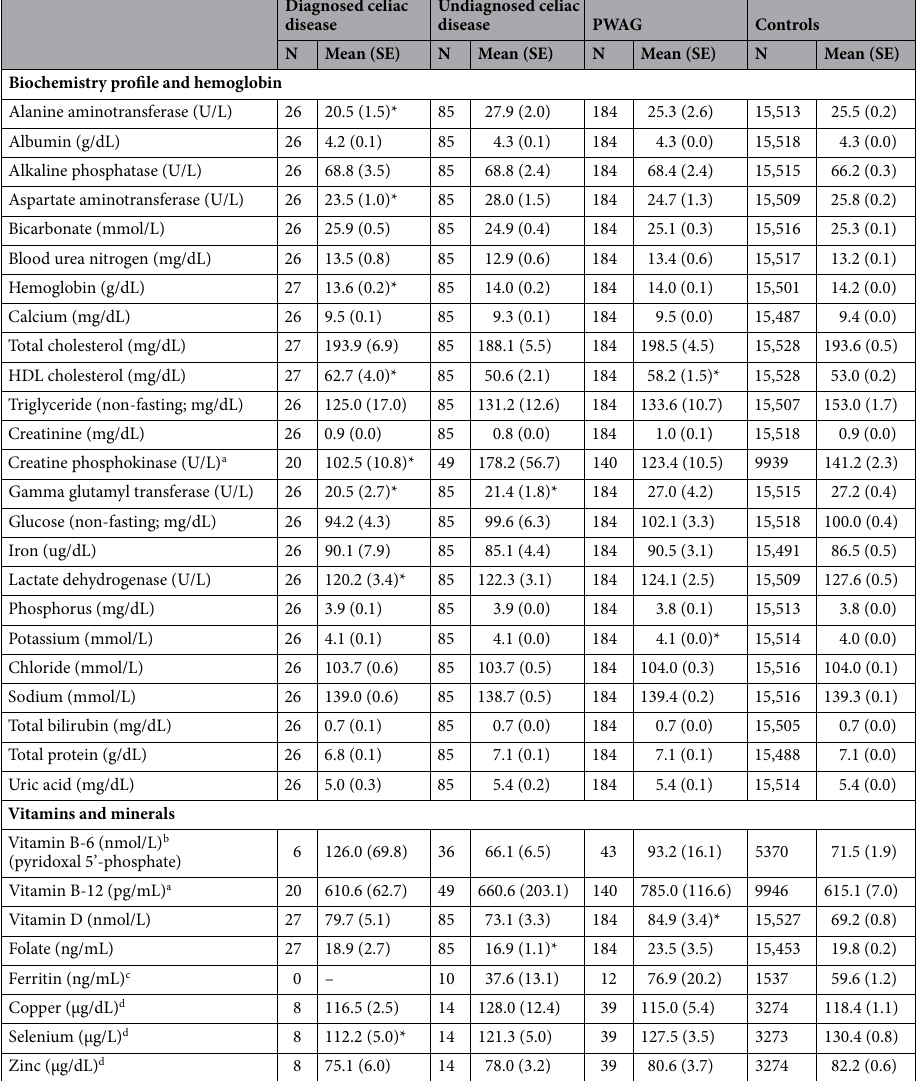
Table 6. Unadjusted mean (SE) serum biochemical and nutritional markers among NHANES participants 20 years and older with and without celiac disease and PWAG, United States, 2009–2014. NHANES, National Health and Nutrition Examination Survey; PWAG, persons without celiac disease avoiding gluten; SE, standard error. a Measured in NHANES 2011–2014. b Measured in NHANES 2009–2010. c Measured on